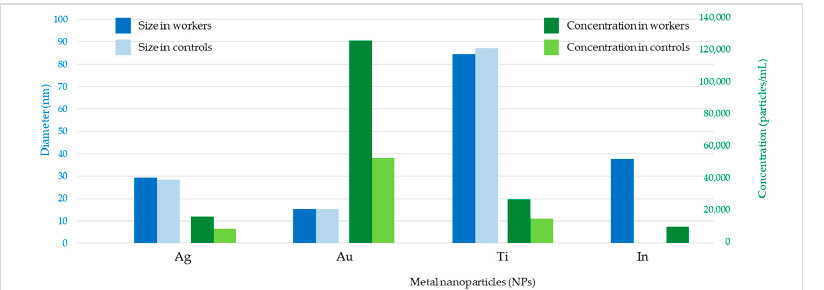
Figure 5. Mean diameter (nm) and number concentration (particles/mL) of metal nanoparticles (NPs) for workers and controls of the two companies. for workers and controls of the two